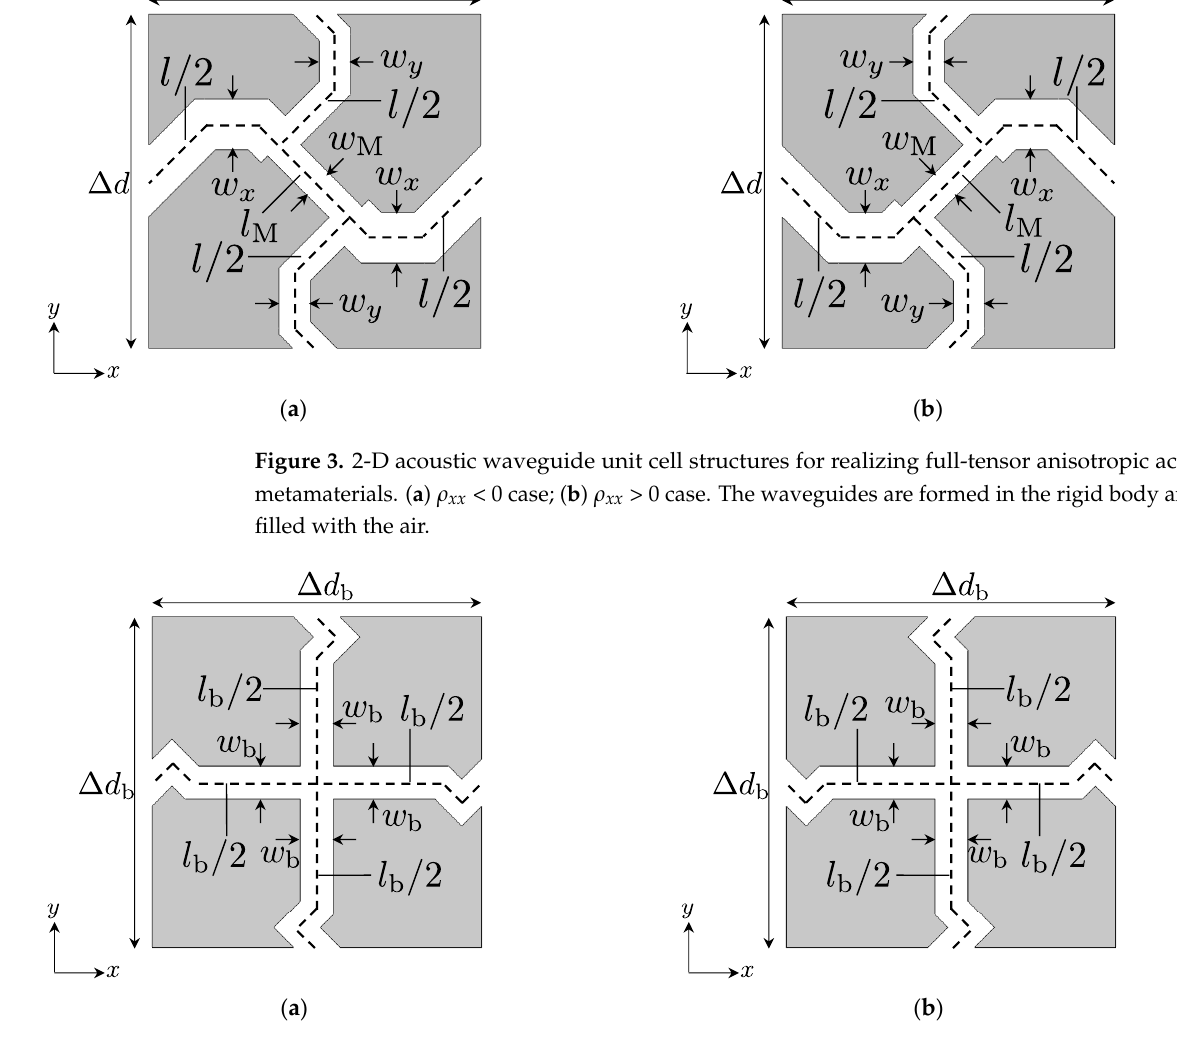
Figure 4. 2-D acoustic waveguide unit cell structures for the background medium. ( a ) For connecting to Figure 3a; ( b ) for connecting to Figure 3b. The waveguides are formed in the rigid body and are filled with the air.